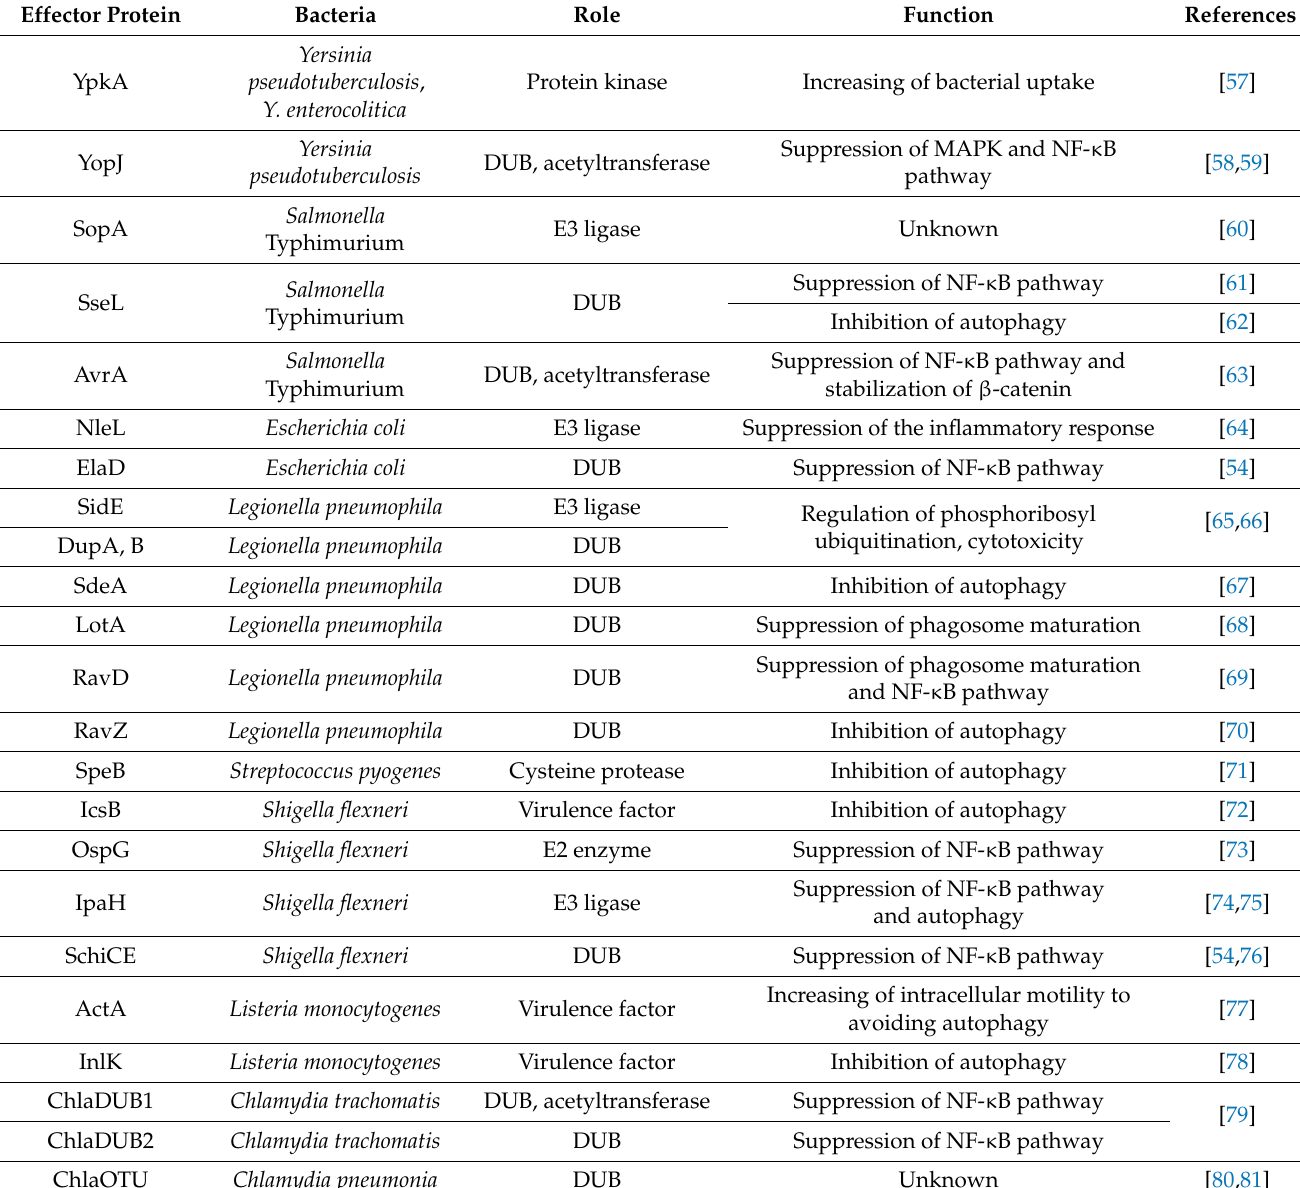
Table 1. Bacterial effector proteins described in this